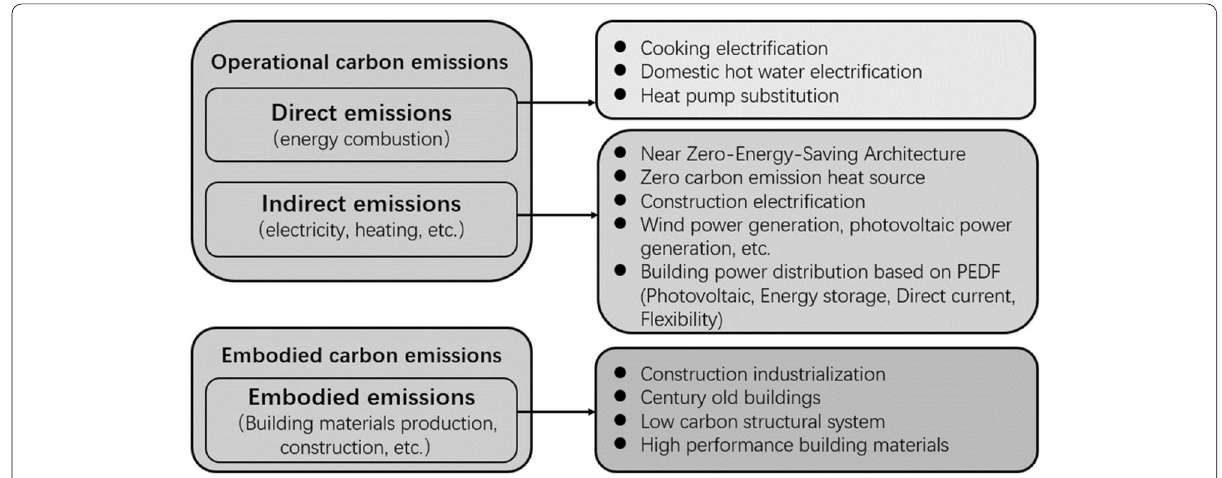
Fig. 1 Building carbon emissions